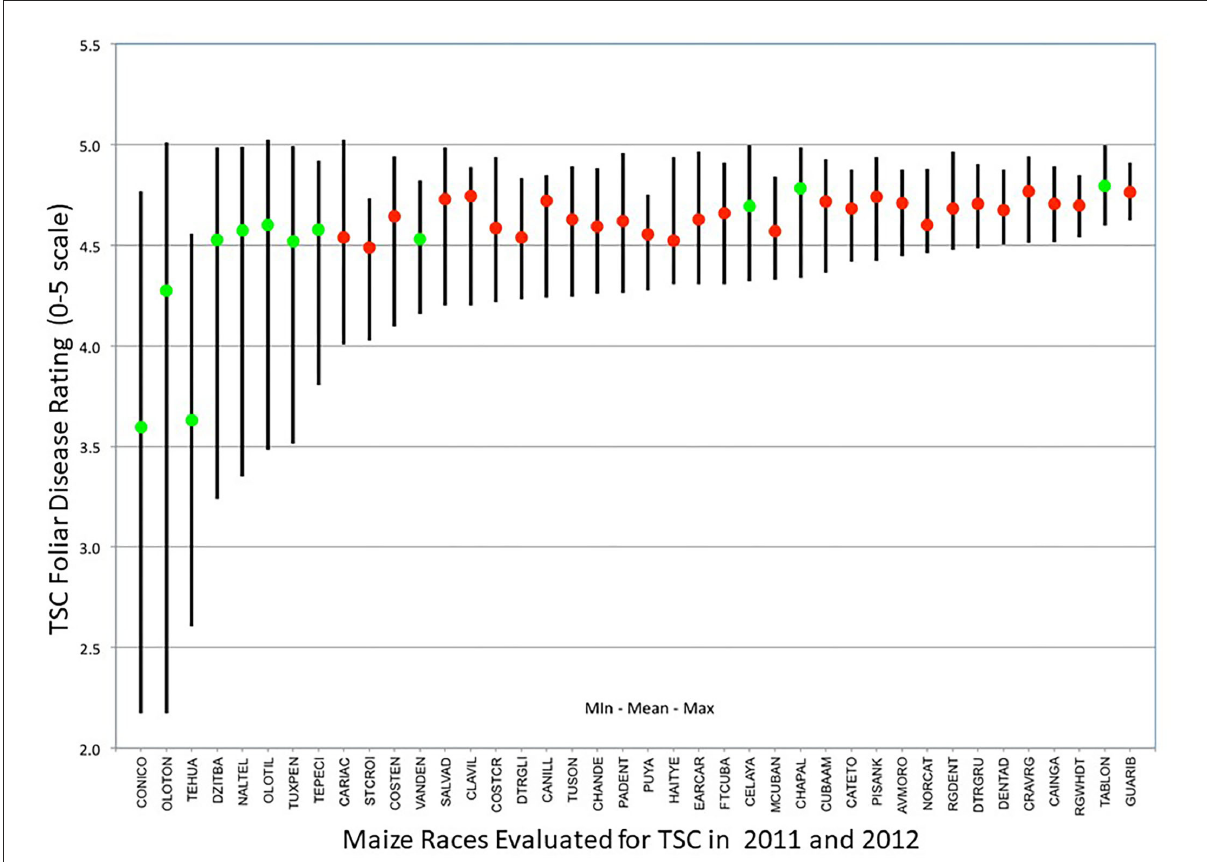
FIGURE3 Differences within maize races (Maize Germplasm Bank designation of accessions) in response to TSC (tar spot complex) shown as means (dots) and ranges (line length) of foliar disease ratings for races where 4 or more accessions topcrosses were evaluated in 2011 and 2012. Native Mexican races are designated by green dots and races from outside Mexico with red dots. Oloton and Tehua (green dots) are accessions collected from regions where TSC has been prevalent and show selectable